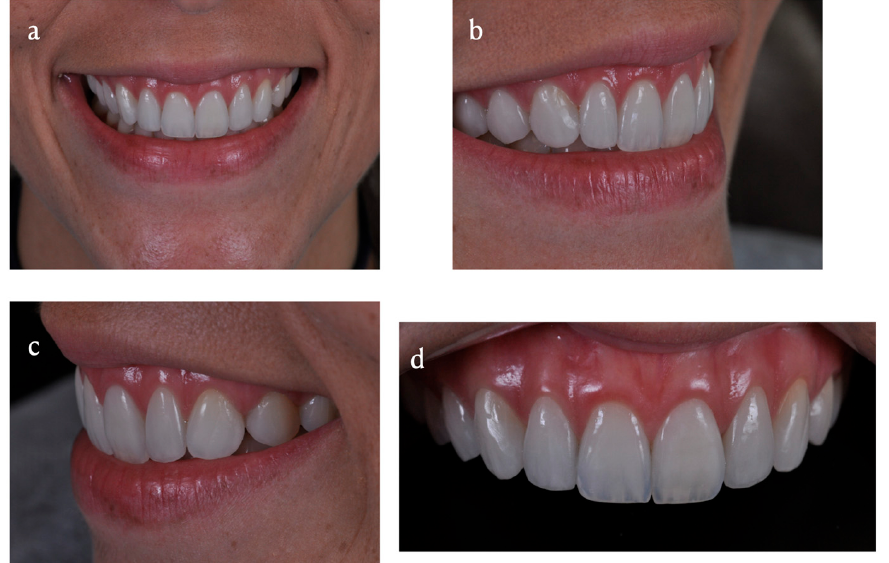
Figure 7. Postoperative views after 30 months, showing maintenance of the ideal biological, functional, and esthetic conditions. ( a ) Extraoral frontal smile. ( b , c ) Lateral extraoral views. ( d ) Intra-oral frontal photo showing maintenance of esthetic conditions after re-polishing.